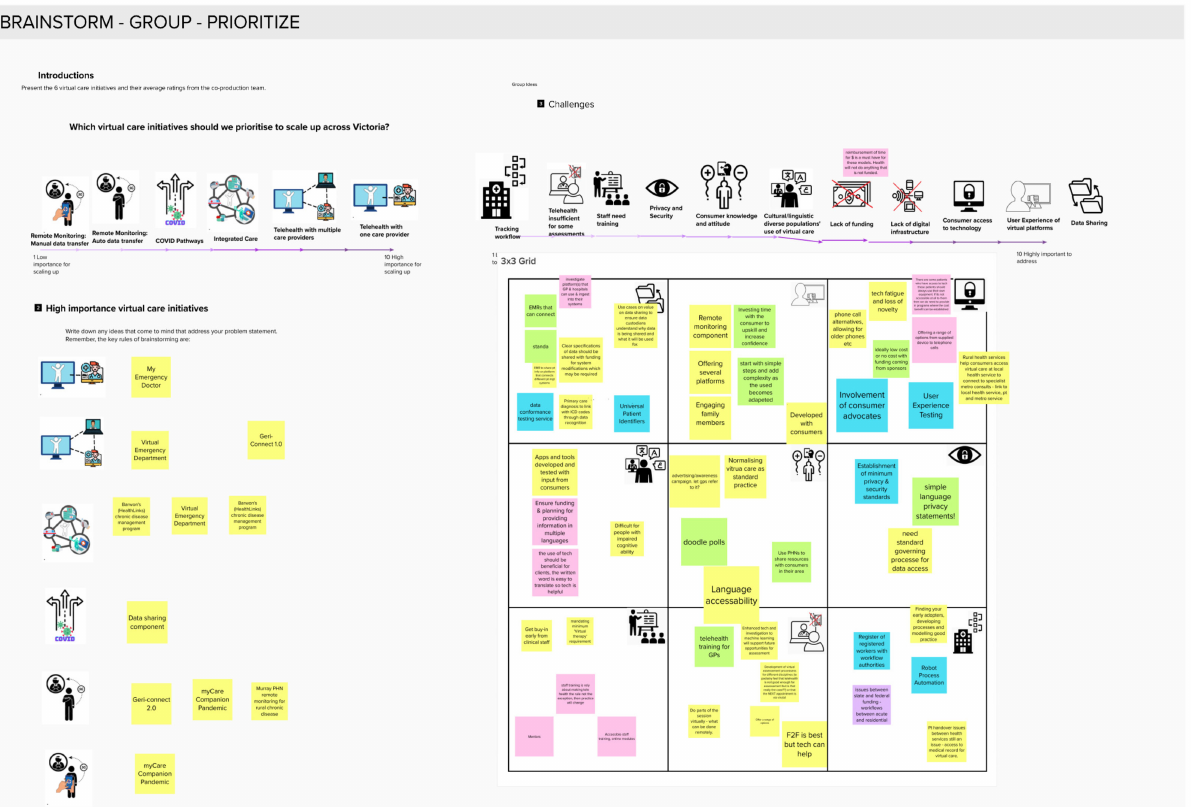
Figure 5. Online visual platform to support group co-production processes and anonymous